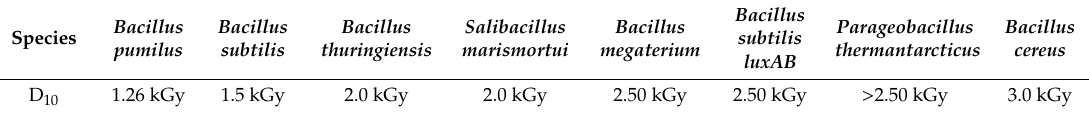
Table 6. D10 values for γ -ray inactivation of spores from di ff erent bacterial